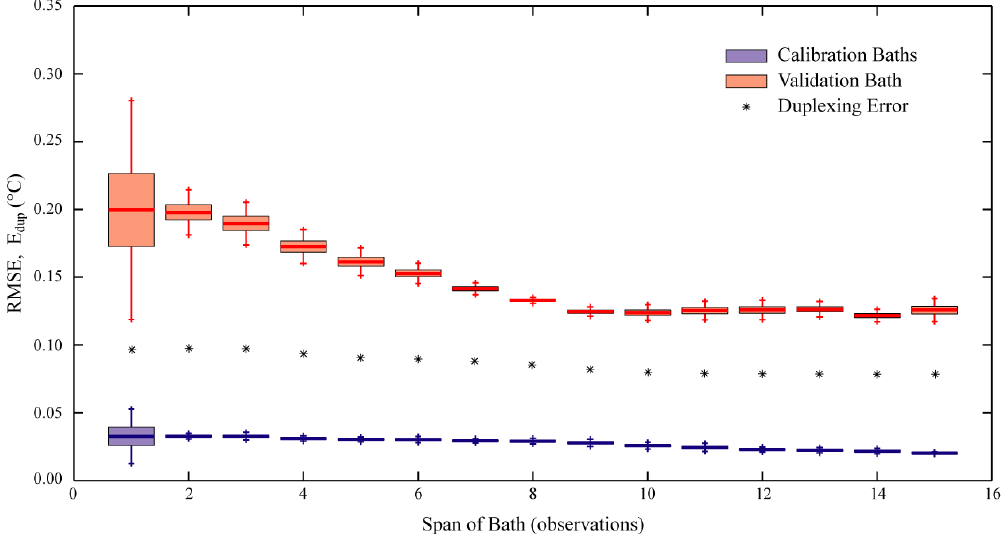
Figure 4. Calibration variations due to length of reference sections. The box and whisker plots indicate the mean RMSE (the heavy horizontal line), three standard deviations (the shaded box), and five standard deviations (the whiskers) in both the calibration baths (blue) and the validation baths (red). The duplexing error in the validation baths is indicated by the black